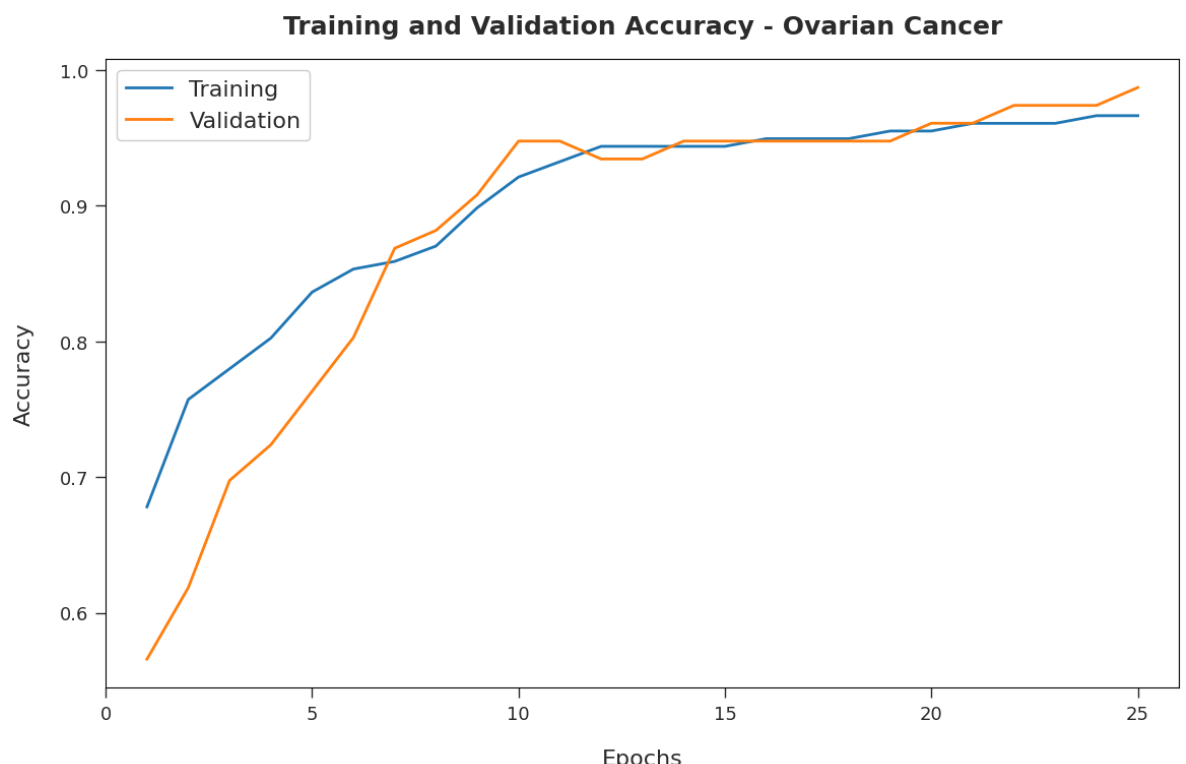
Figure 10. Accuracy analysis of RFODL-MGEC technique with ovarian cancer dataset. Figure 11 exemplifies the training and validation loss inspection of the RFODL- MGEC technique on the ovarian cancer dataset. The figure shows that the RFODL-MGEC system offered reduced training/accuracy loss for the classification process of the test data.